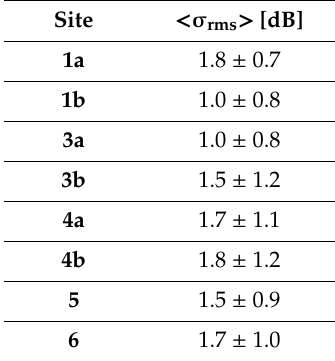
Table 3. Summary of results: comparison between DYNAMAP predictions and measurements in all